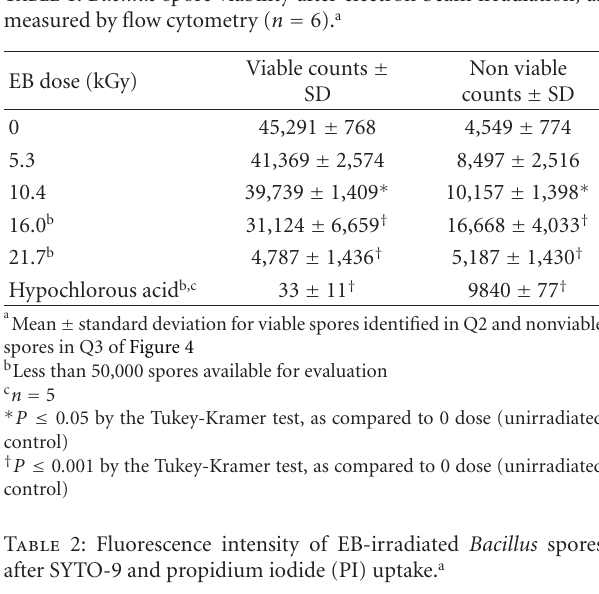
Table 1: Bacillus spore viability after electron beam irradiation, as measured by flow cytometry ( n = 6). a